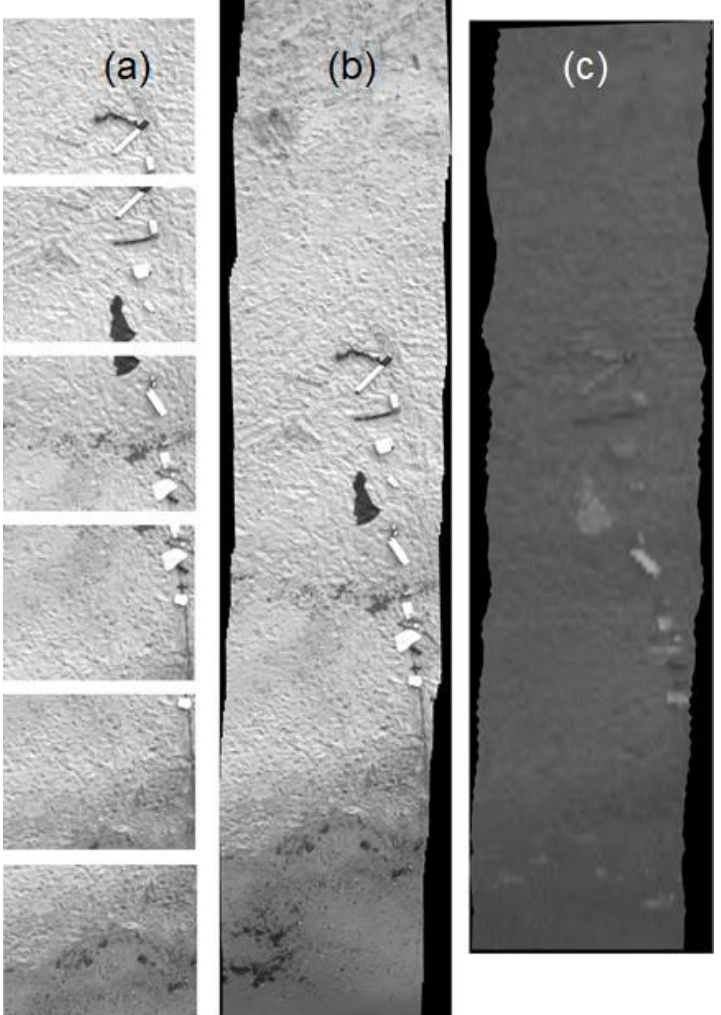
Figure 6. ( a ) Selection of images acquired during one of the flights above the seashore; ( b ) result of the mosaicking procedure applied to 154 images; ( c ) image at wavelength 1050 nm extracted from the corresponding hyperspectral cube.